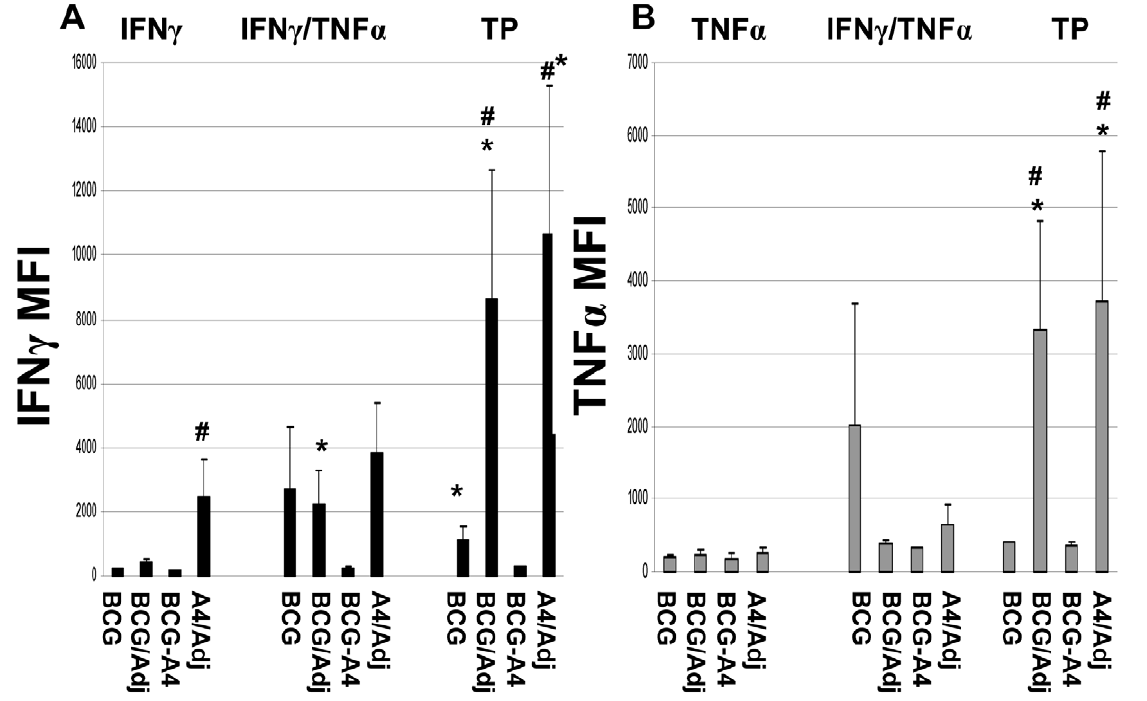
Figure 5. Median fluorescence intensity (MFI) of (A) IFN c or (B) TNF a in monofunctional or multifunctional CD8 T cells. The data are presented as the mean of individual MFI values for 4–5 mice per vaccine group. *Statistical significance relative to monofunctional cytokine expressing cells, p , 0.05. # Significant differences relative to BCG in the same T cell subset, p , 0.05.